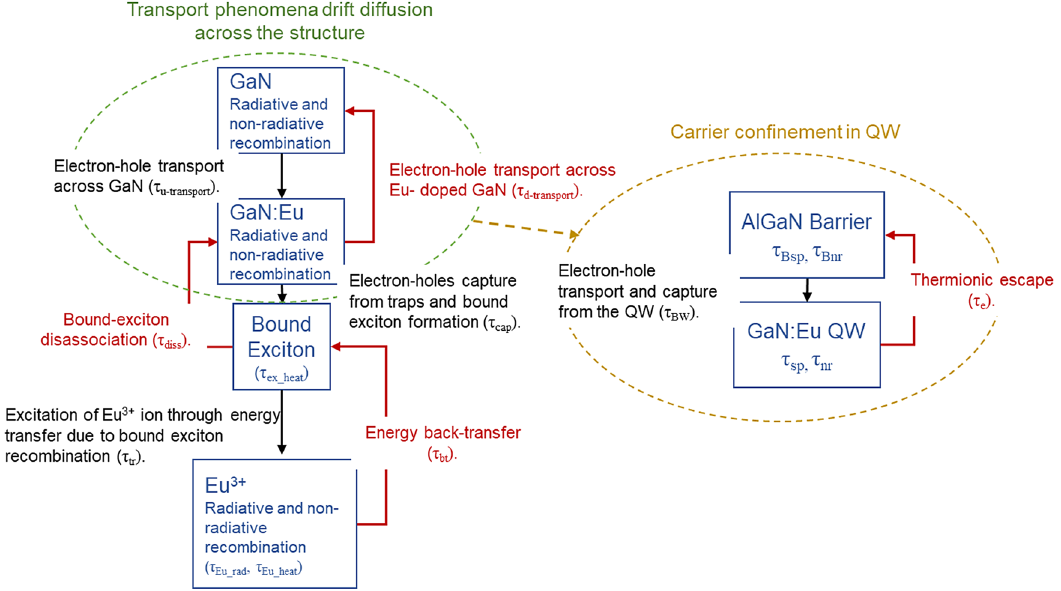
Figure 11: Excitation path in Eu-doped GaN-based LED devices. Black arrows indicate the transition of electron-hole pairs into the next level and red arrows represent the energy recycling mechanisms. [Reprinted (adapted) with permission from a study by Fragkos et al. [210], Copyright 2017, Springer